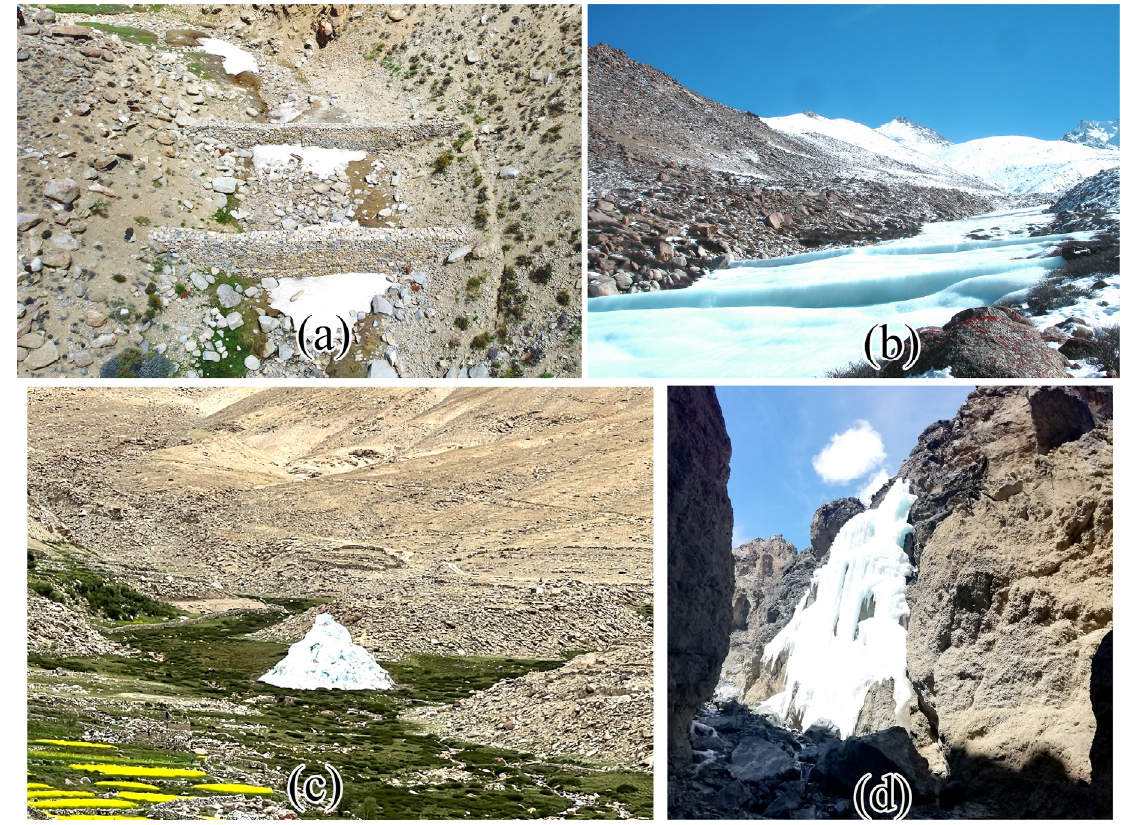
Figure 6. Various Ice reservoir techniques from the study villages-( a ) Artificial glacier from Umla village, ( b ) Artificial glacier from Igoo village during winter, ( c ) Ice stupa from Igoo village, ( d ) Ice fall glacier from Takmachik village (Source: ( a , b ): Authors; ( c ): NGO staff, LNP; ( d ): NGO staff LEHO). Table 3. Natural glaciers and Ice reservoirs in the study